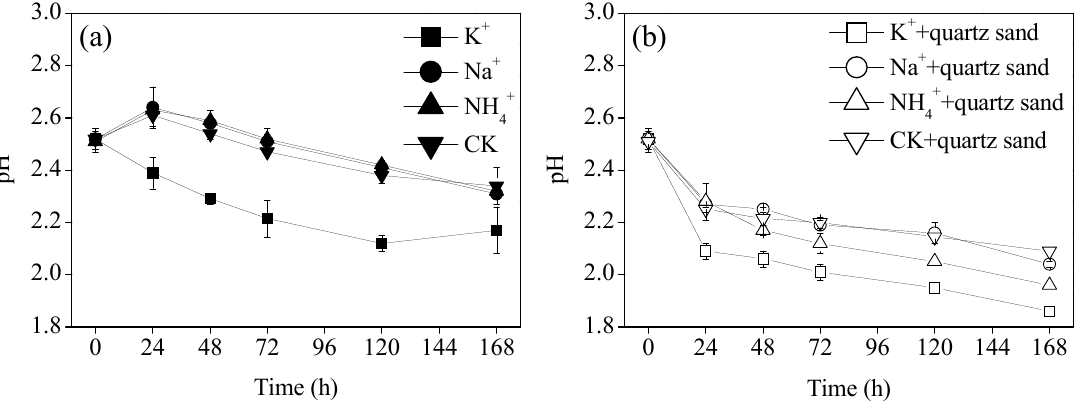
Figure 2. Change of pH ( a ) without and ( b ) with quartz sand in simulated acid mine drainage (AMD) system.